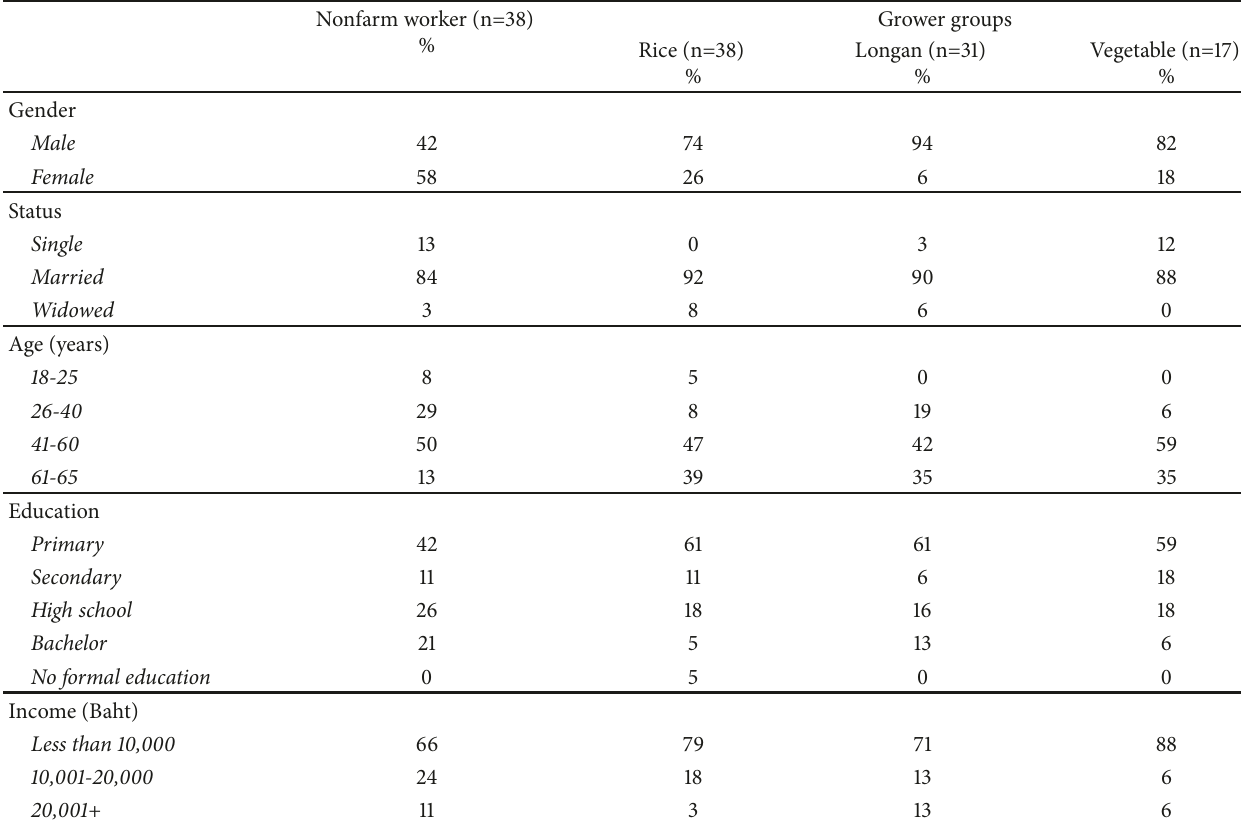
Table 2: Percentage distribution of sociodemographic characteristics, by study group